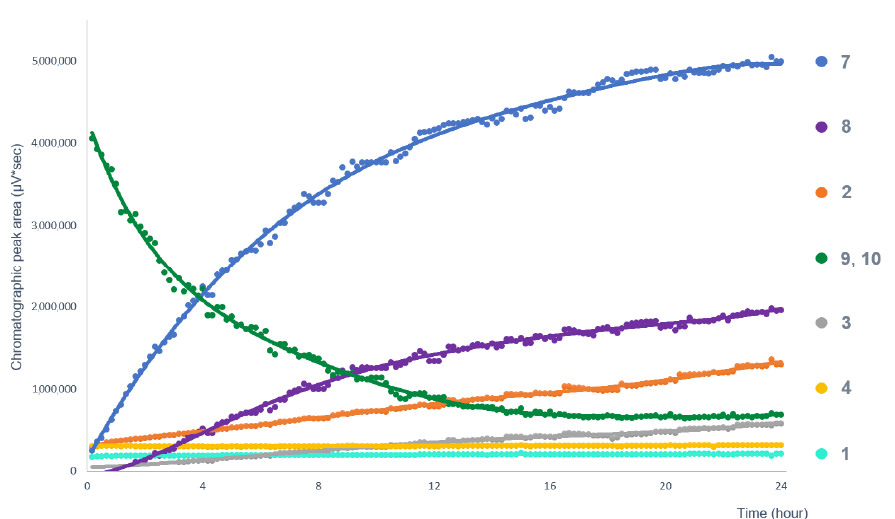
Figure 2. Changes in the composition of the A. galanga ethyl acetate extract in PBS solution. The change in the chromatographic peak areas of the compounds is plotted as a function of time.